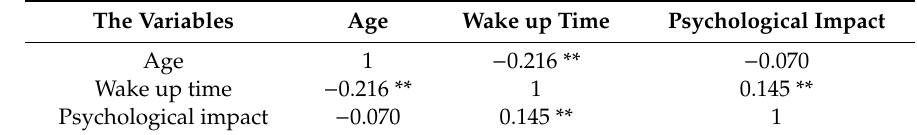
Table 4. The correlation matrix between the age and time of waking up and the psychological impact during the first confinement of the coronavirus pandemic COVID-19 in Algeria. The Variables Age Wake up Time Psychological Impact Age 1 − 0.216 ** −